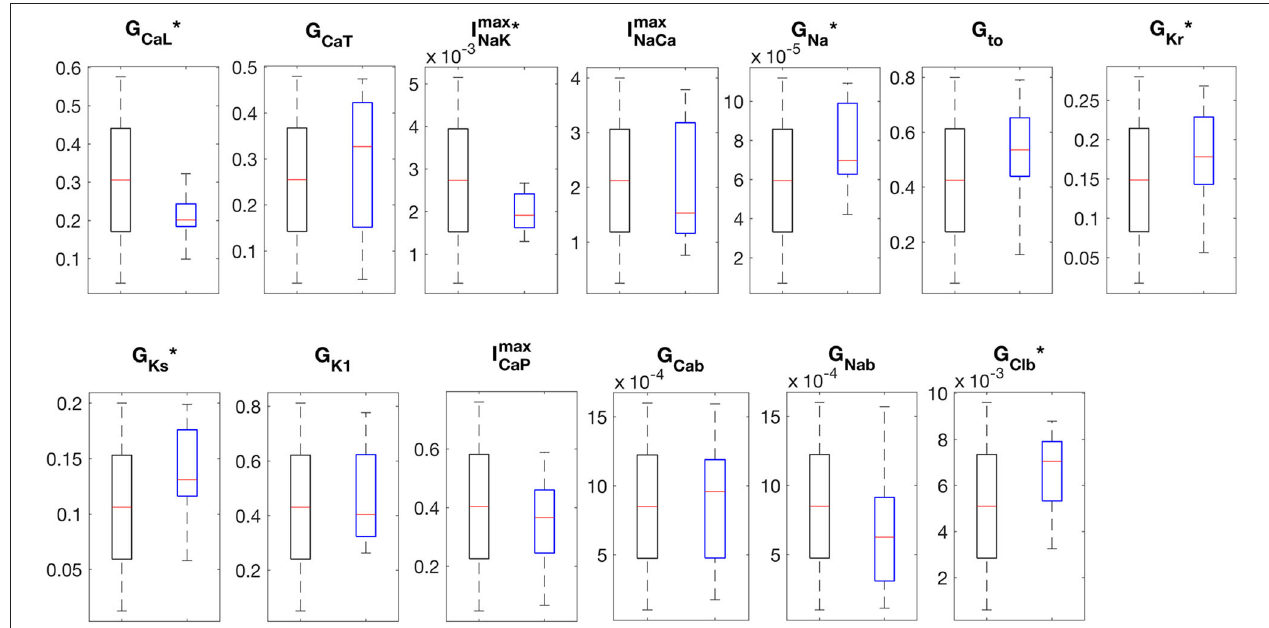
FIGURE 5 | Boxplots of the distributions of maximum conductances. The “*” indicates distributions that were significantly different between the original (black boxes, n = 3000) and control populations (blue boxes, n = 16) (Kolmogorov-Smirnov test, p -val < 0.05).